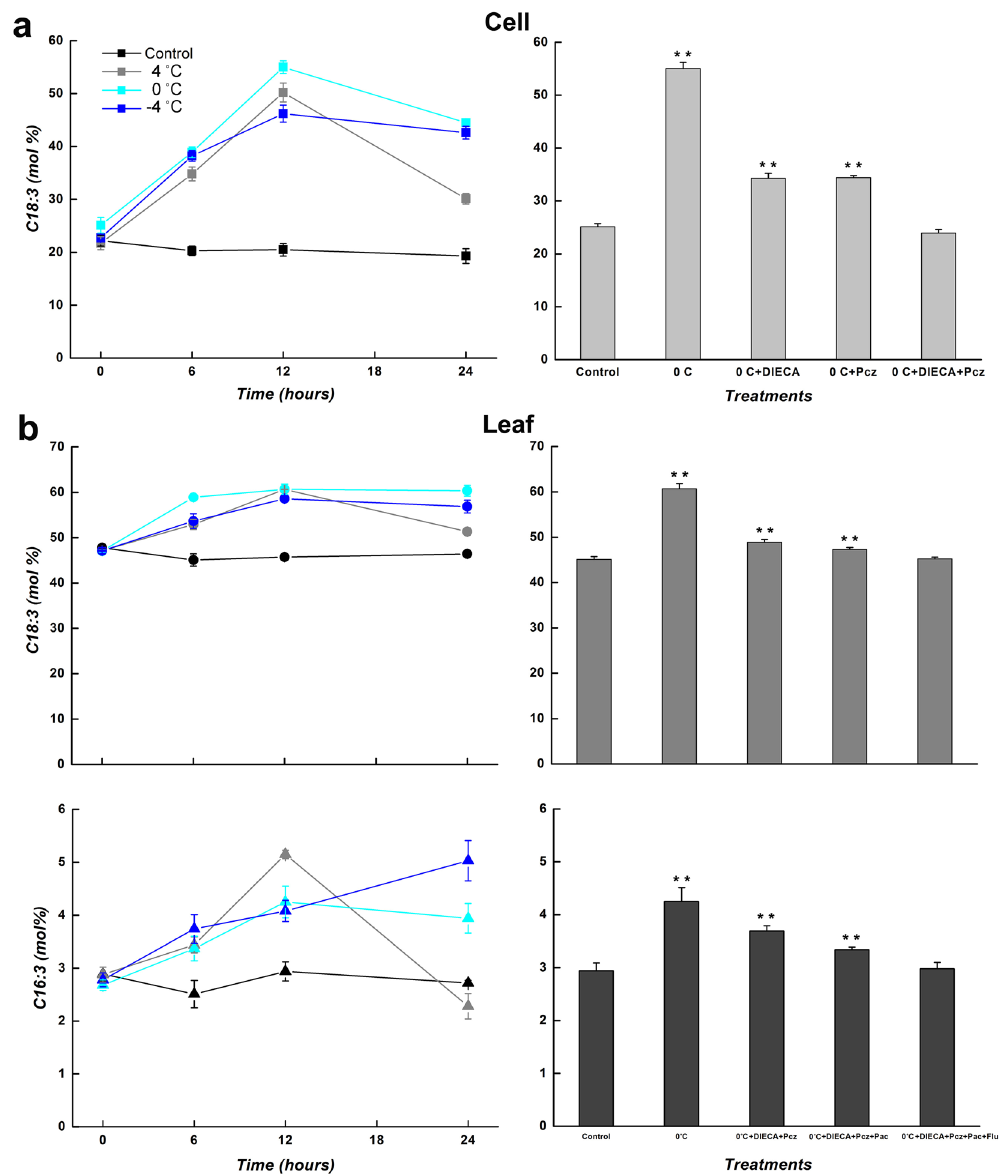
Figure 8. Levels of TAs in C. bungeana under low-temperature and hormone-inhibition treatments. ( a ) Levels of C18:3 in the total lipids of suspension-cultured cells. ( b ) Levels of C18:3 and C16:3 in the total lipids of the leaves from regenerated plants. The data of inhibition treatments were detected at being treated for 12 h. The corresponding data at the same time point under normal conditions was taken as the control. Each value represents the mean ± SE of five replicates. The content of C18:3 in cell lipids and leave lipids as well as the content of C16:3 in leave lipids are indicated by square, circle and triangle,